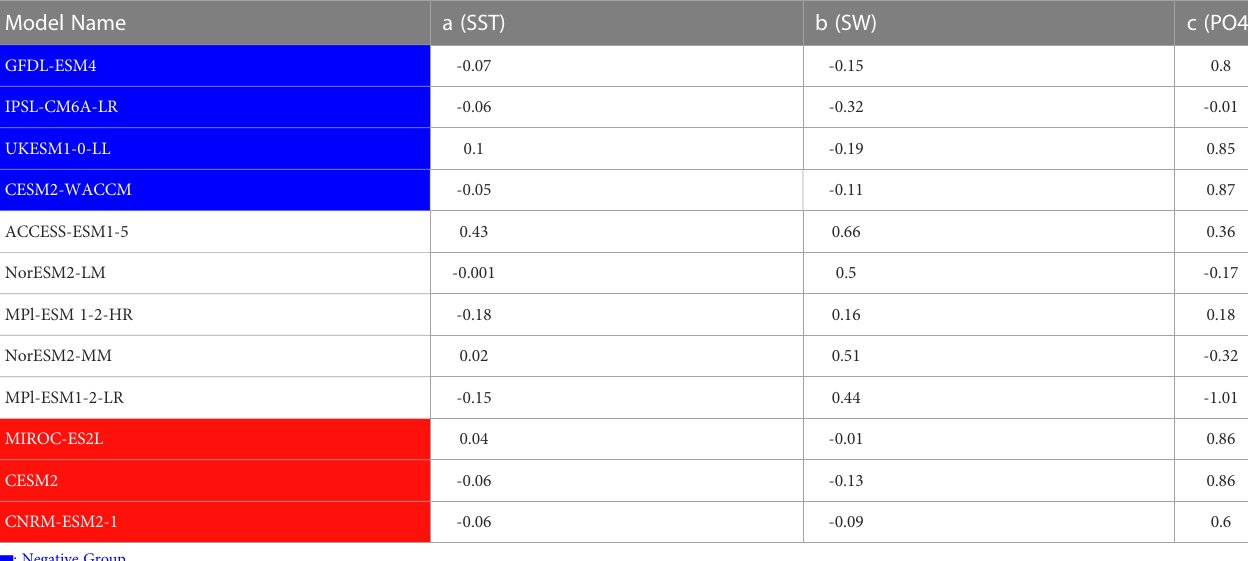
TABLE 1 Multiple Regression coef fi cients of Sea Surface Temperature (SST), Shortwave radiation (SW), and PO 4 for 12 CMIP6 models of historical climate period (except for CanESM5 which DIP data are not